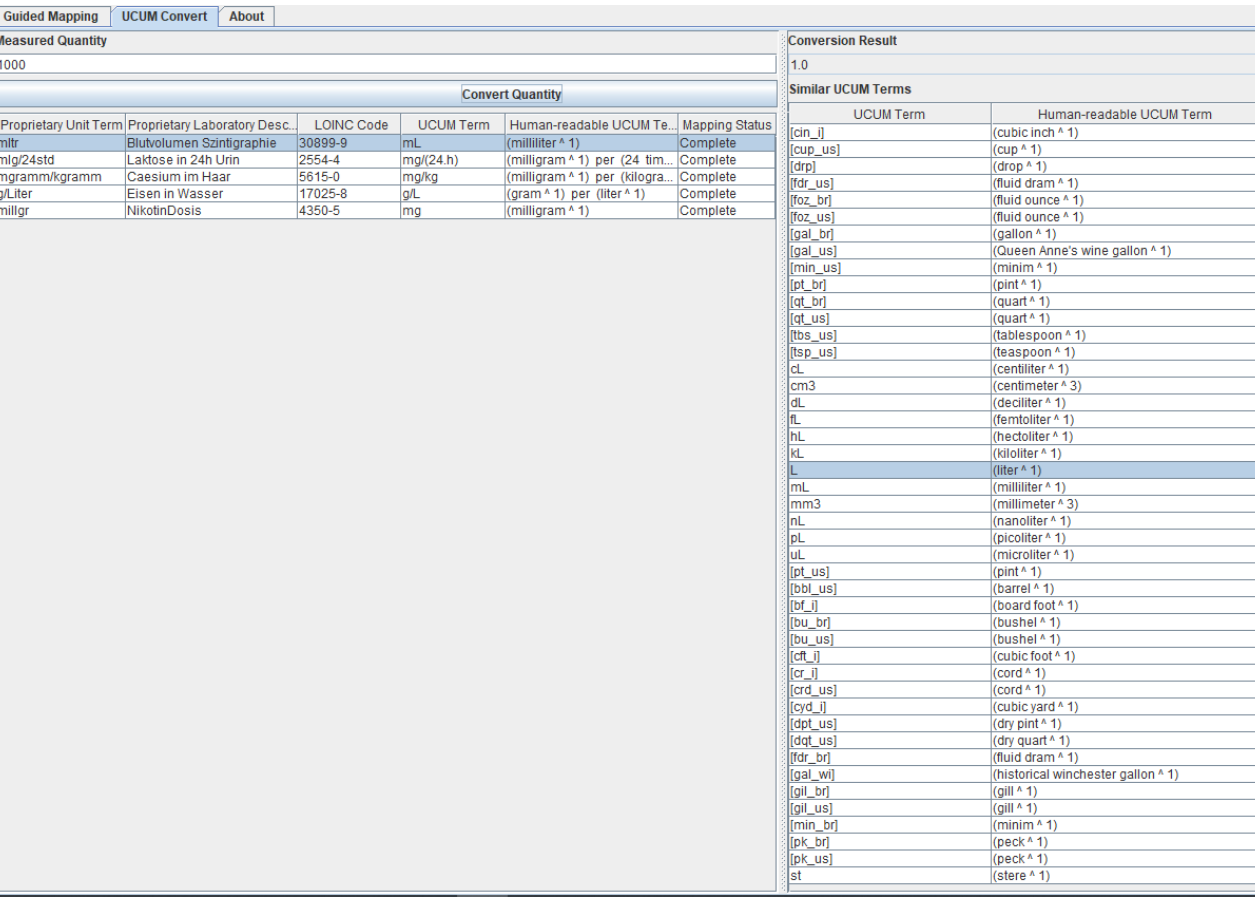
Figure 7. In the conversion window, users may now perform unit conversions by selecting one of their proprietary units and the UCUM unit they want to convert it